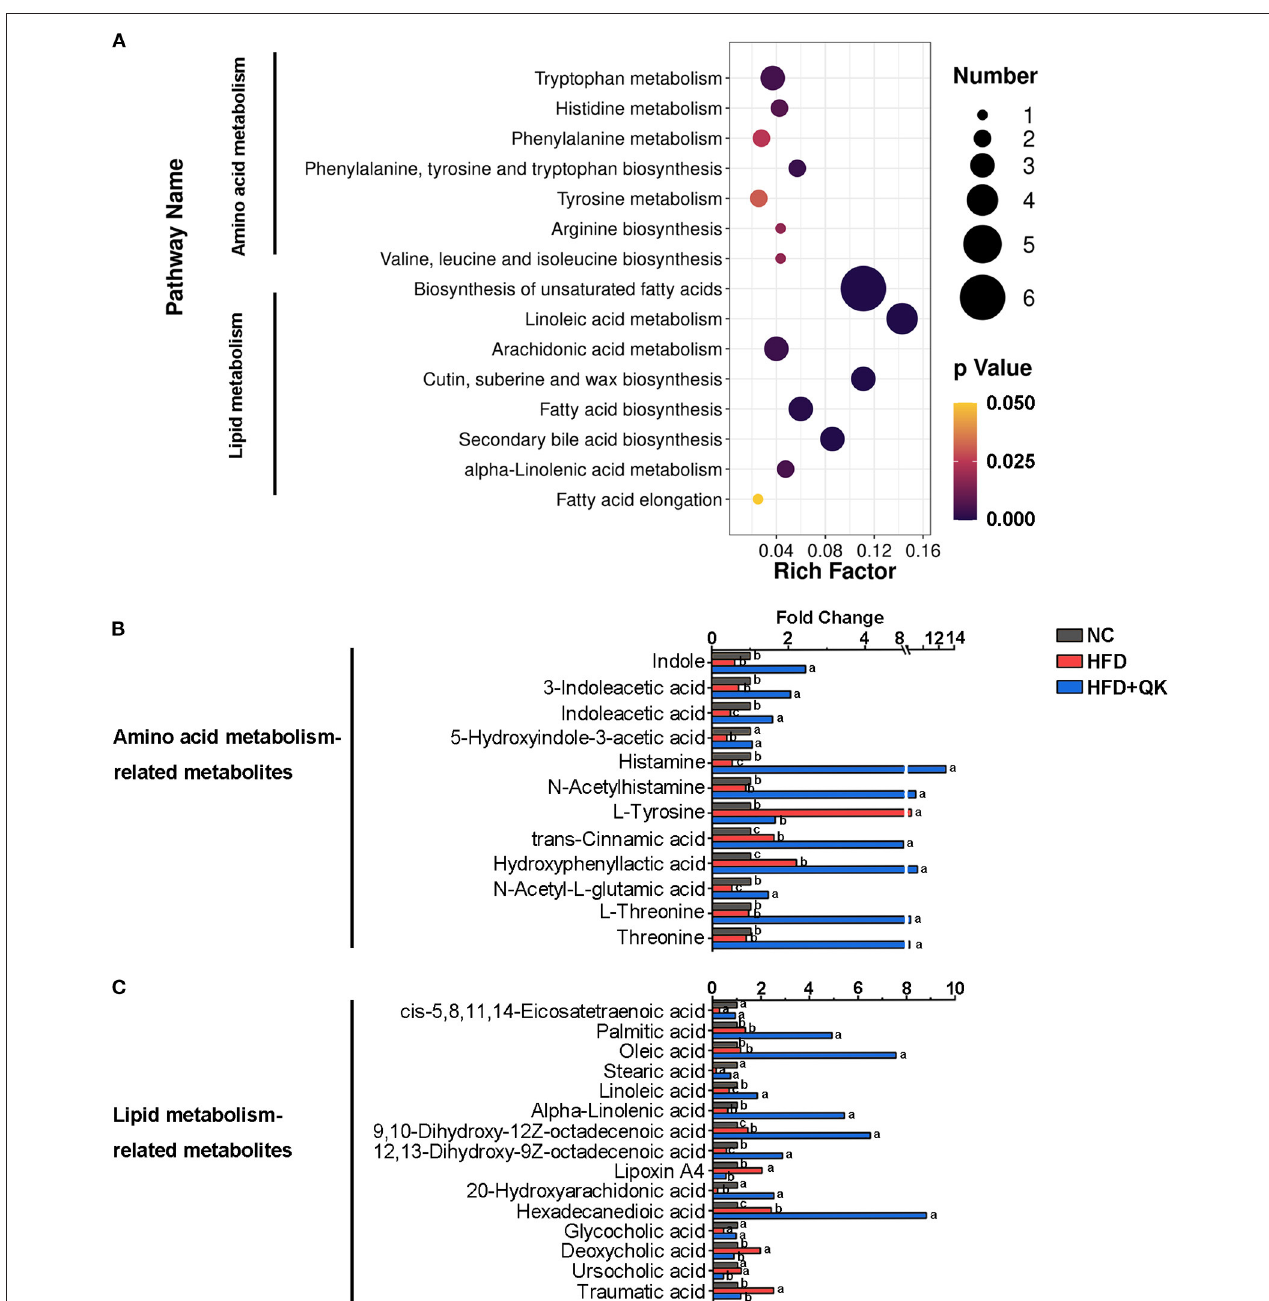
FIGURE 6 | Effects of WGQK on fecal metabolites. (A) KEGG Enrichment Scatter Plot of Amino acid metabolism and lipid metabolism. Rich Factor = S_metabolites_Number/B_metabolites_Number, the size of the bubble indicates the amount of significantly differential metabolites which are enriched in this pathway, and the point with different gradation of color represents the scope of p -value. The higher value of rich factor stands for the higher degree of enrichment, and the lower p -value represents the more significant degree of enrichment; (B,C) The fold change of metabolite abundance involved in (B) amino acid metabolism, and (C) lipid